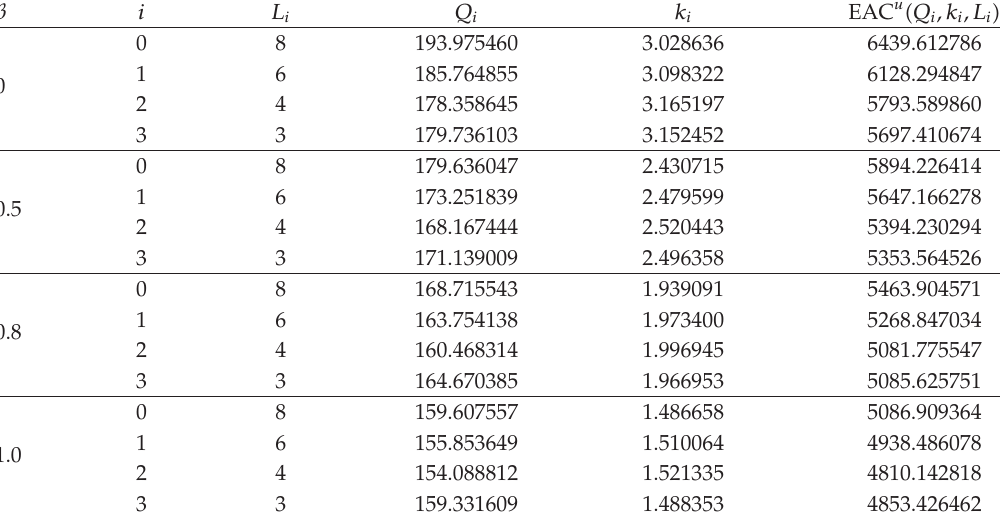
Table 2: Our minimum solution for L i with i (cid:6) 0 , 1 , 2 ,